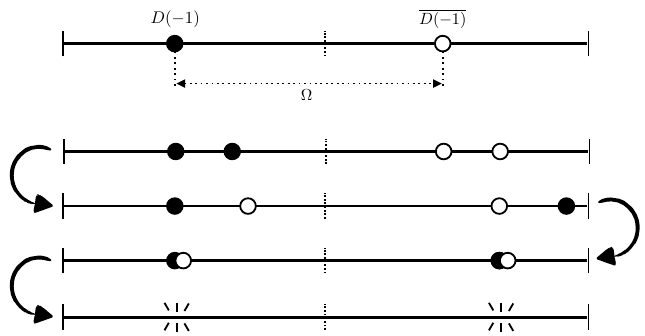
Figure 2 . Picture of the DP background via its covering S 1 . The two ends of the interval must be identified, forming a circle. The DP background is obtained by restricting to configurations invariant under a half-shift combined with an action of Ω . In the top panel of the figure, we illustrate one such configuration, consisting of a D ( − 1) brane (black dot) and an D ( − 1) (white-filled dot) in a shifted position. This configuration couples to the Z field C , and is stable. Putting two such 2 0 objects together allows for their decay by positioning the antibrane of one of the pairs on top of the brane of the other, as illustrated in the successive steps in the bottom